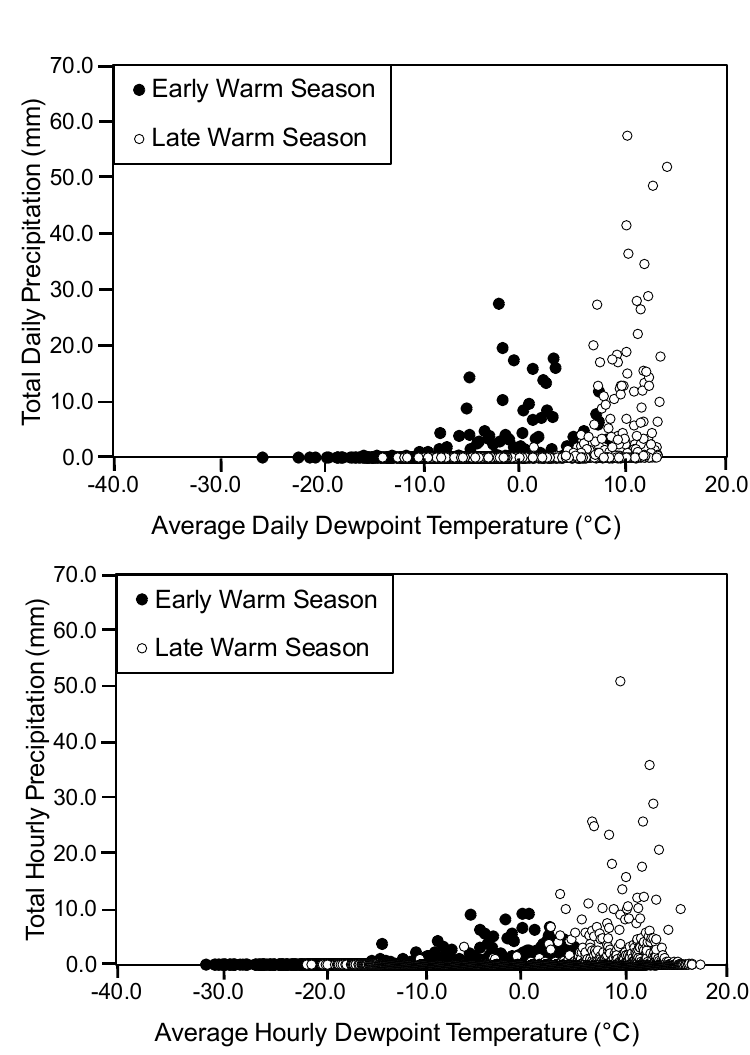
Figure A1. Total precipitation plotted against average dewpoint temperature for early and late warm season at our study site. The larger precipitation events occurred during the late warm season as dewpoint temperature